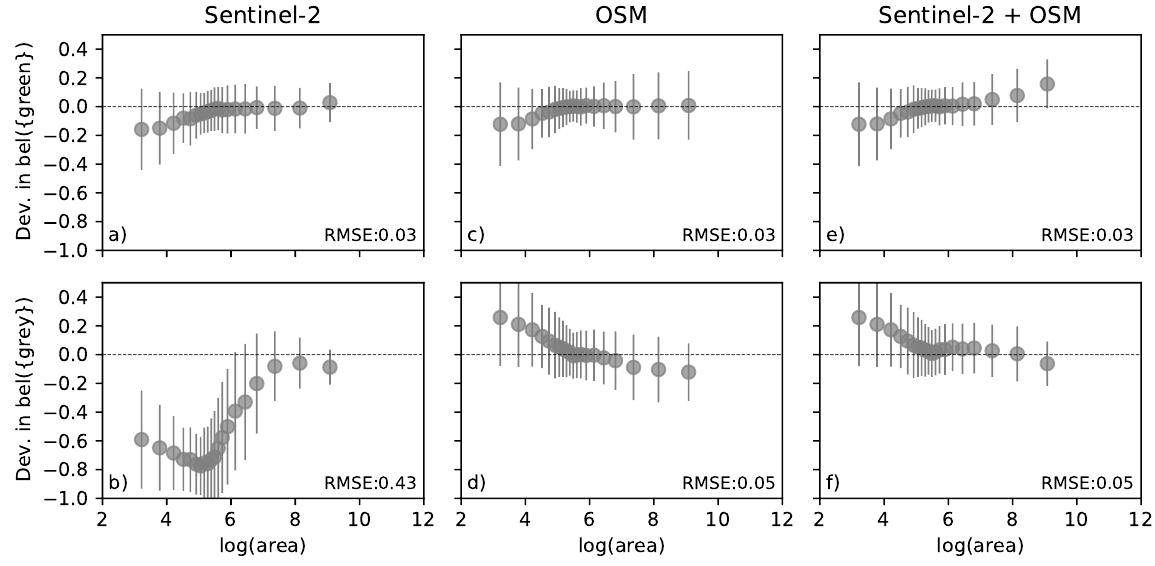
Figure 7. Deviation in beliefs about greenness for land use polygons of different size compared to the ground truth derived from aerial imagery. Deviations in bel ( green ) and bel ( grey ) from Sentinel-2 ( a ) + ( b ), from OSM ( c ) + ( d ) and from Sentinel-2 fused with OSM ( e ) + ( f